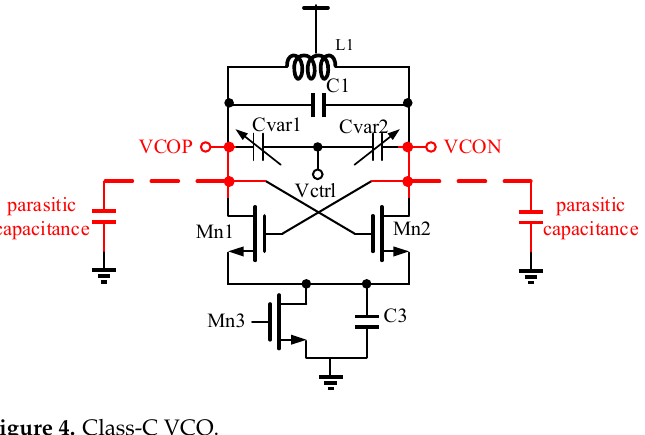
Figure 4. Class-C